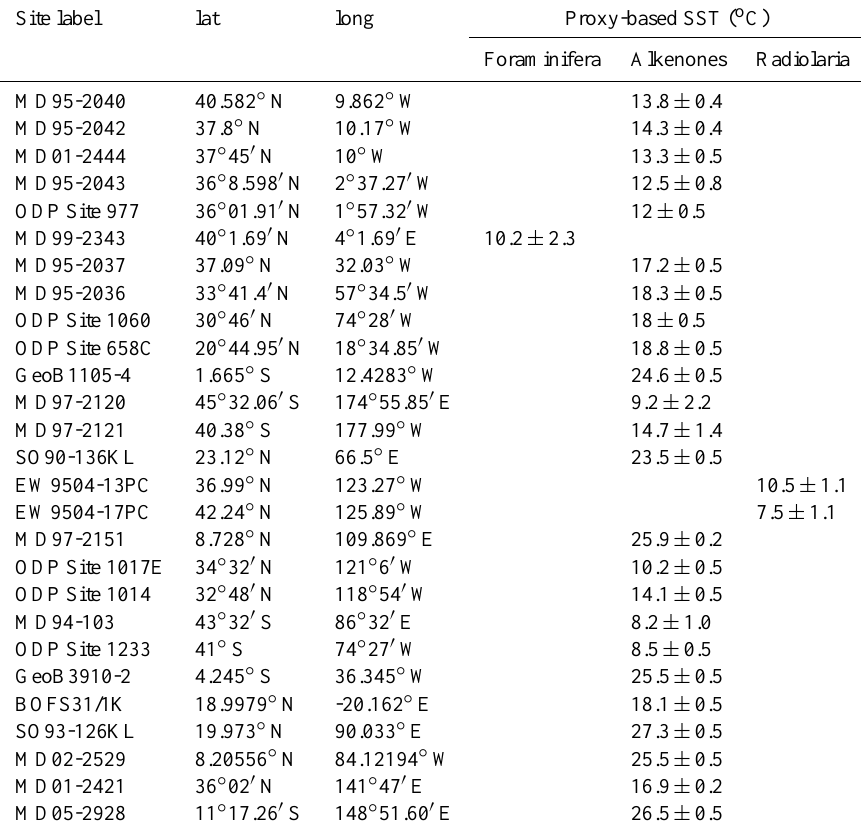
Table A5. Proxy based SST data for annual mean conditions with ± 1 σ error (given either by the author(s) of the respective data or estimated by the authors of this